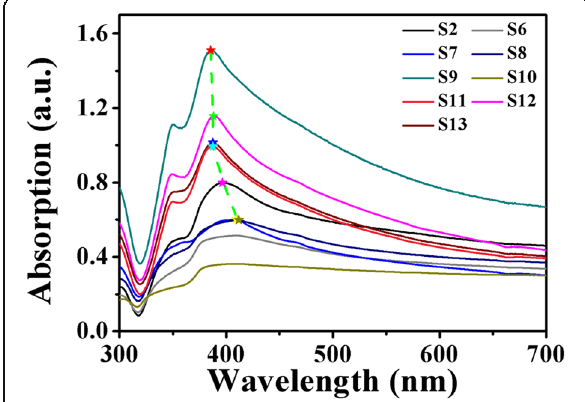
Fig. 4 UV-visible absorption spectra of as-prepared Ag NWs with different